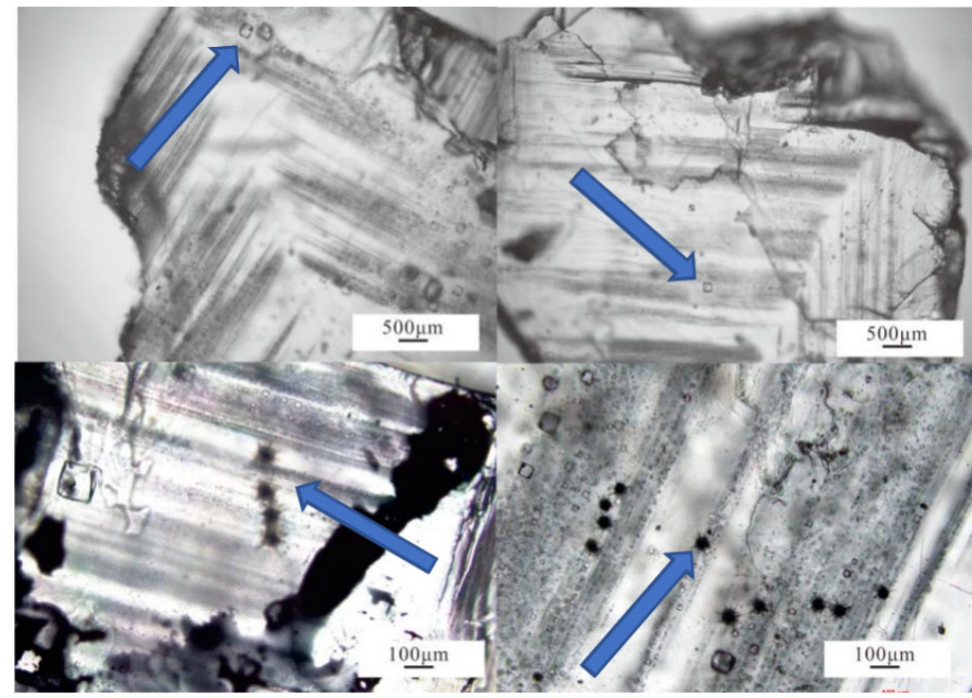
Figure 4. Primary fluid inclusions in halite.